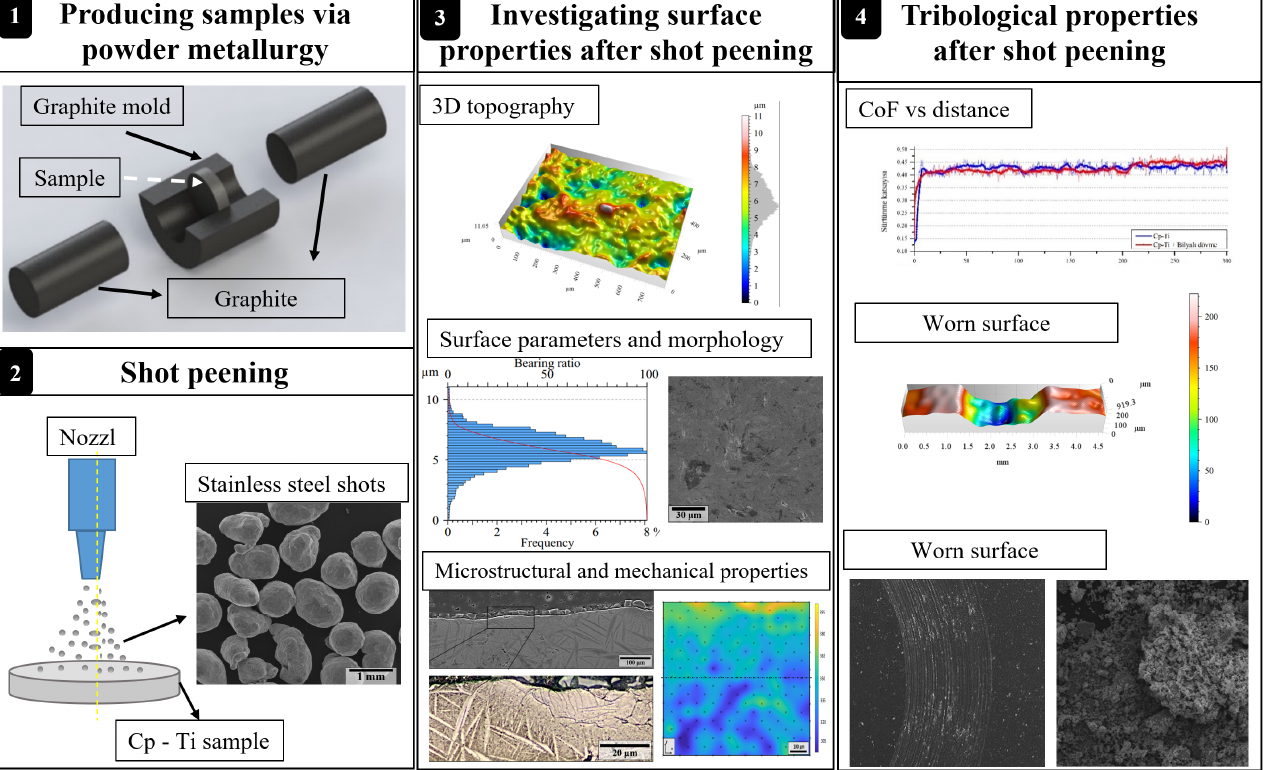
Figure 1. Outline of the present study.